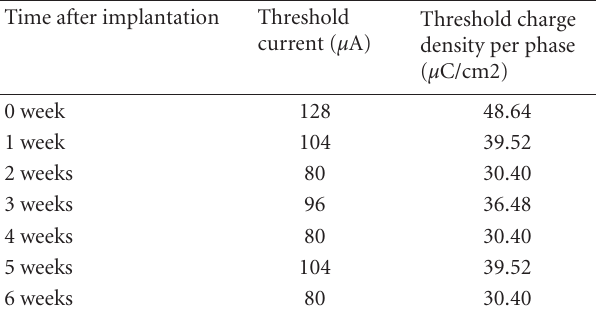
Table 3: Threshold current to elicit the EECP. Seven channels were used simultaneously and the duration of the pulse was a bipha- sic current pulse, 1ms/phase with a 1-millisecond interphase delay. The repetition rate was 4 Hz. 0 week means the day of